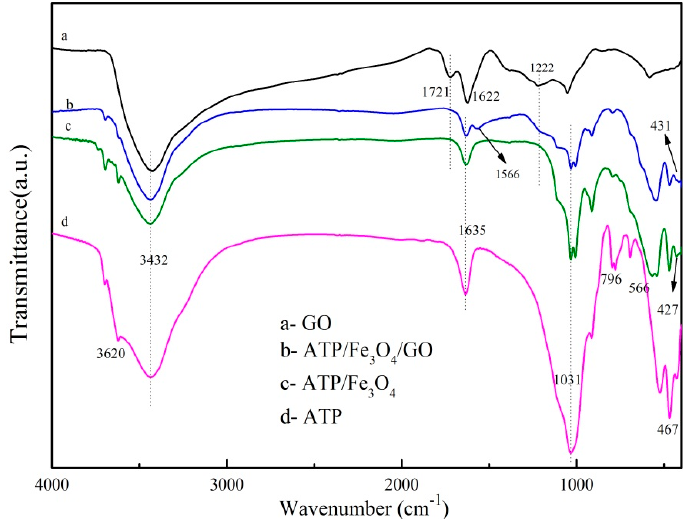
Figure 1. The FTIR spectra of graphene oxide (GO), Attapulgite (ATP)/Fe 3 O 4 /GO, ATP/Fe 3 O 4 , and ATP.